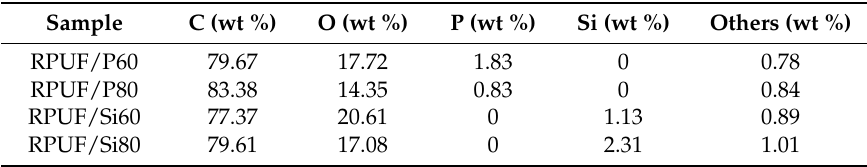
Table 7. EDAX data of the residue of